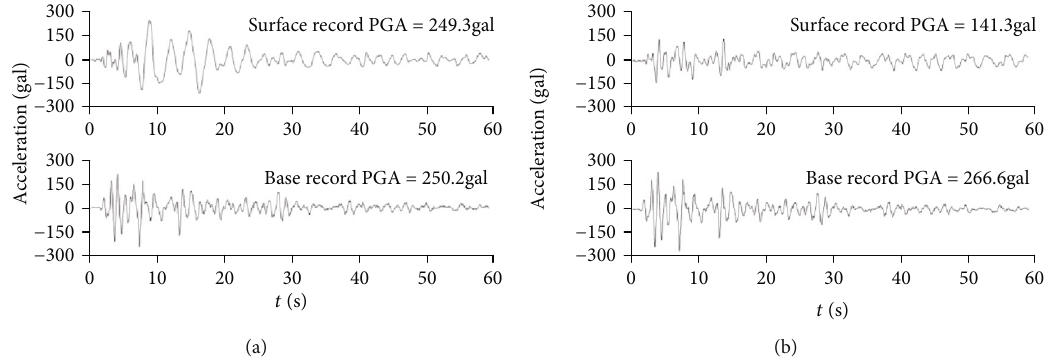
Figure 5: Acceleration time history response of EL – 4 situation: (a) model 1 and (b) model 2.